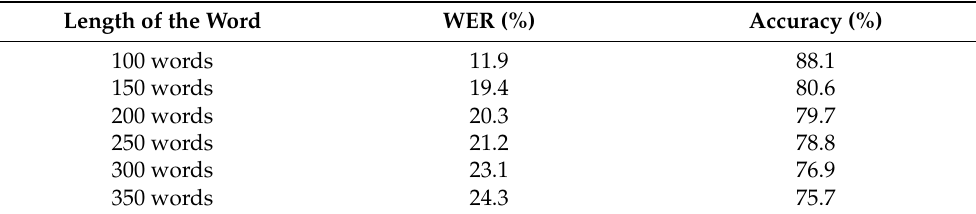
Figure 9. ( a , b ) Time waveform and Spectrogram of speech signal using NSS. The enhanced speech signal is converted into text using the HMM or the DTW-based text conversion algorithm to find the accuracy level of the enhanced speech signal. Table 4 represents the WER calculated for the enhanced speech signal using the NSS. Table 4. WER and its percentage using NSS. Table 4. WER and its percentage using NSS.